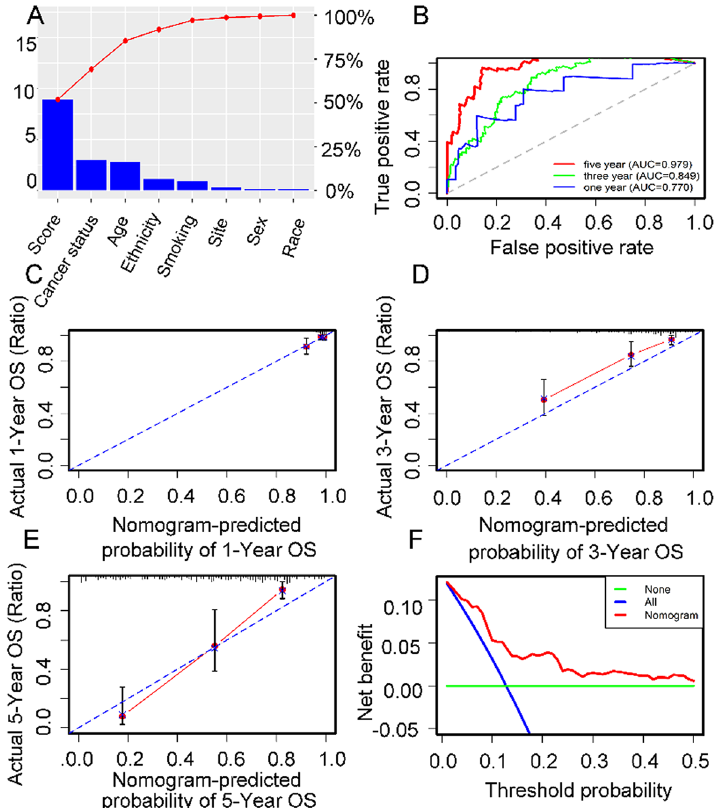
Figure 8. Analysis of the 11-DNA methylation biomarker-related nomogram in the entire TCGA dataset. ( A ) The horizontal axis stood for clinical factors, the vertical axis stood for the percentage of importance. ( B ) 1-, 3-, 5-year ROC curves for the 11-DNA methylation biomarker-related nomogram. ( C – E ) referred to the 1-, 3-, 5-year nomogram calibration curves, respectively. ( F ) The DCA for the nomogram. The net benefit was plotted versus the threshold probability. The red line represented the nomogram. The blue line represented the treat-all and the green line represented the treat-none.